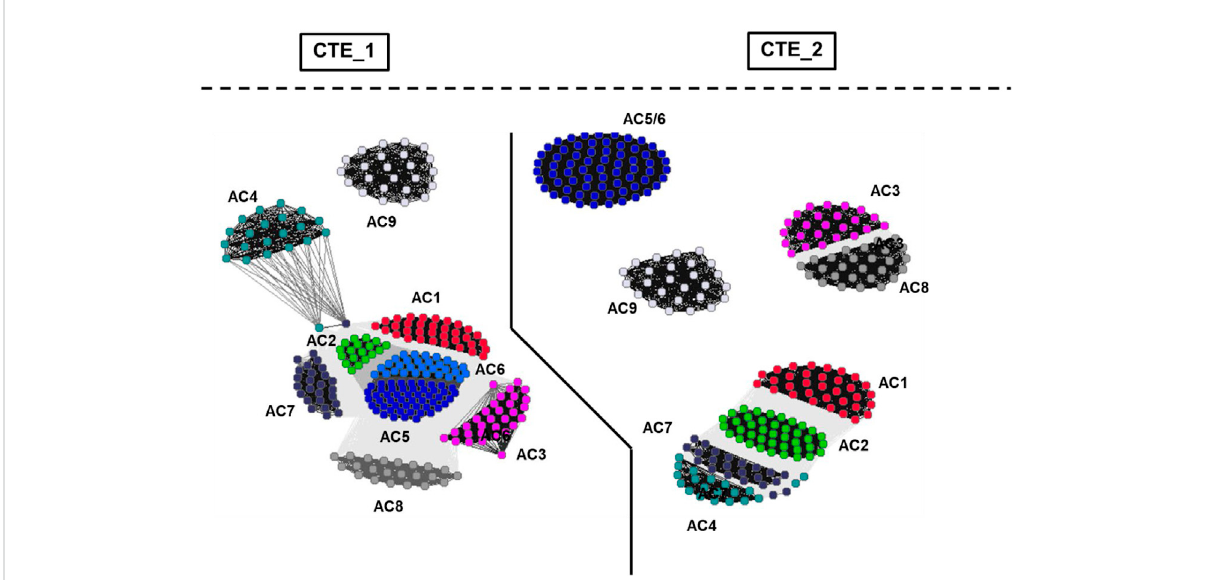
FIGURE 6 Clustermapofcyclase-transducing-elements(CTEs).Forpreparationofthe fi gure,thedatasetfromZiegleretal.(2017)wasused.Thebacterial sequences were removed and vertebrate class IIIa CTEs were analyzed using CLANS (Frickey and Lupas, 2004). Each dot represents a single sequence. The CTE_1 and CTE_2 sectors are separated by a solid line. Cluster labeling indicates the mAC isoform. The segregation shows that CTEs from class IIIa ACs are highly speci fi c for their C1- and C2-domain origins as well as for AC isoforms.